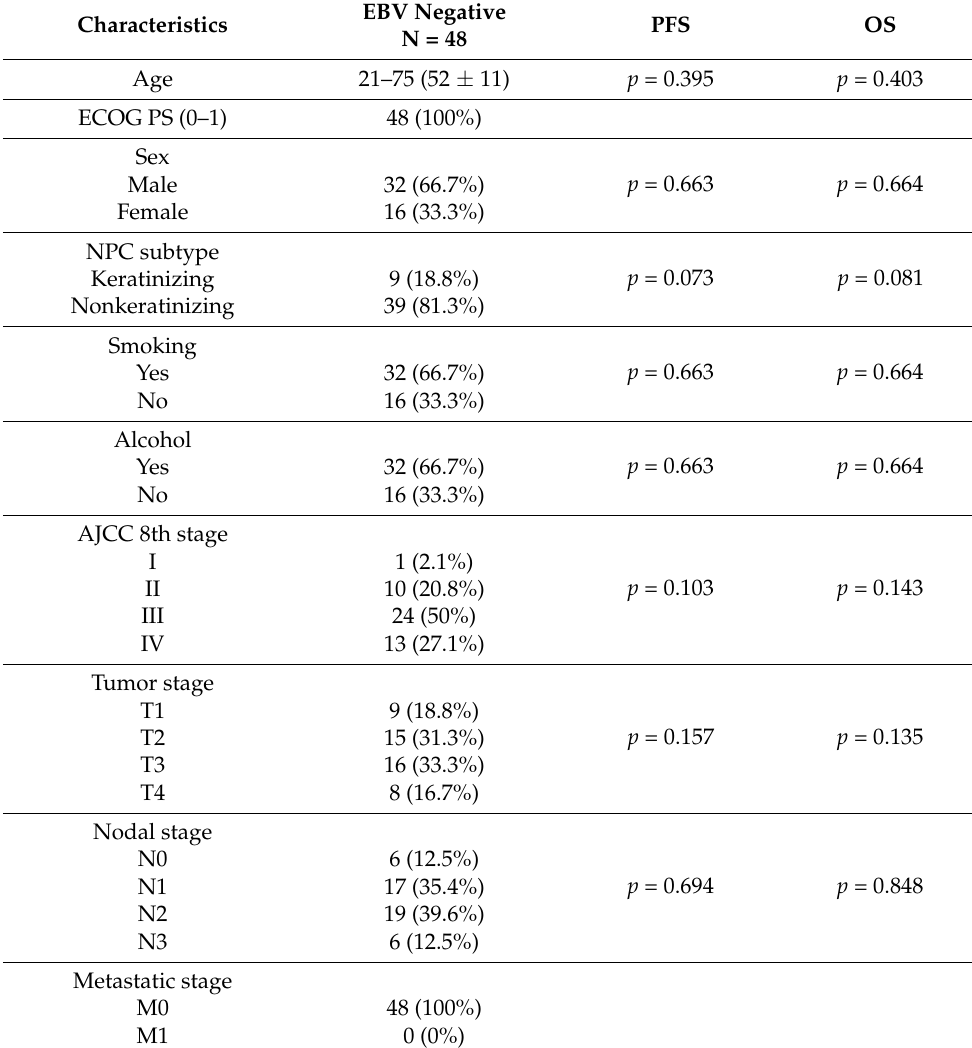
Table 1. Clinicopathological features of EBV-negative NPC